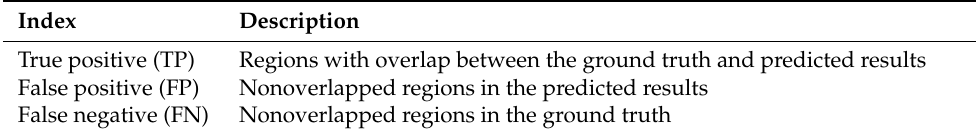
Table 1. Description of the preliminary calculations used to evaluate the segmentation